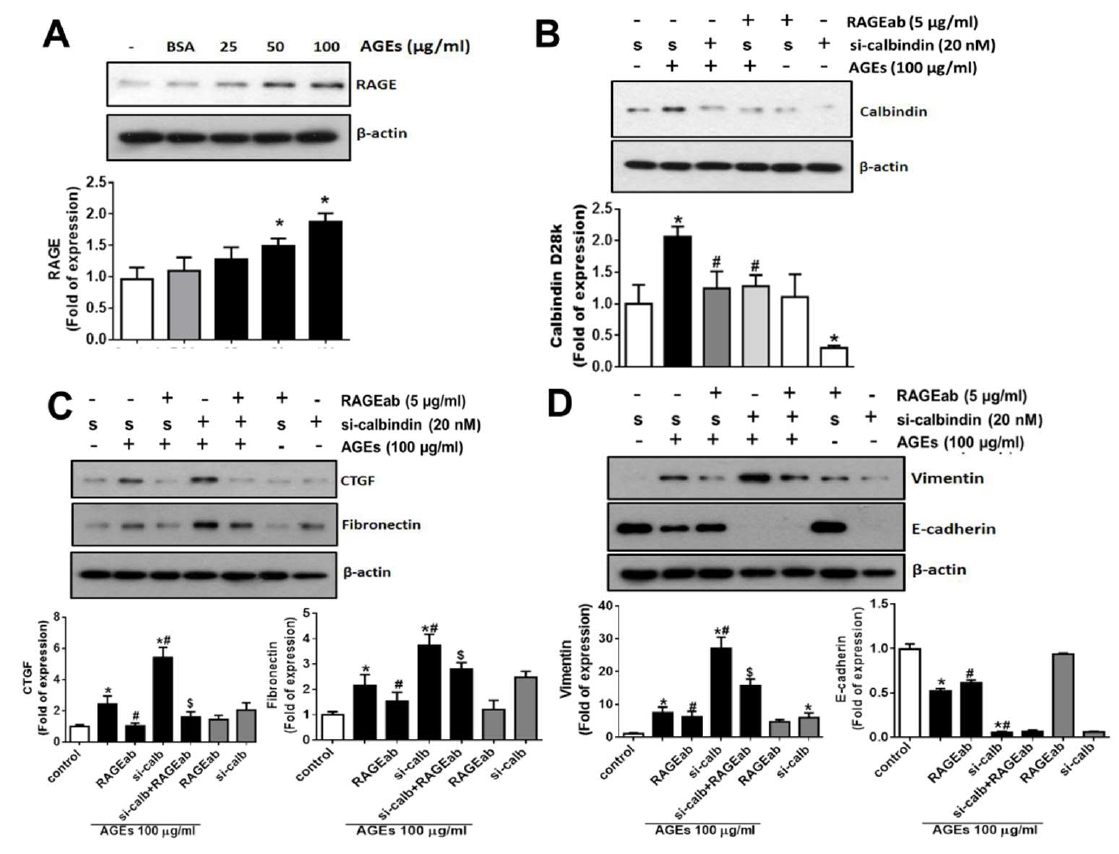
Figure 4. RAGE blockade suppressed AGEs-induced fibrotic signals and calbindin-D28k in the presence or absence of calbindin-D28k silencing in HK2 cells. ( A ) Cells were treated with AGEs (25–100 µ g / mL) or BSA (100 µ g / mL) for 48 h. Protein expressions of RAGE in HK-2 cells were determined by Western blotting. In ( B – D ), cells were transfected with scramble (s or control; 40 nM) or calbindin-D28k siRNA (si-calbindin or si-calb; 40 nM) for 6 h. Transfected cells were treated with RAGE neutralizing antibody (RAGEab, 5 µ g / mL) for 1 h, and then treated with AGEs (100 µ g / mL) for 48 h. Protein expressions of calbindin-D28k ( B ), CTGF and fibronectin ( C ), and vimentin and E-cadherin ( D ) in HK-2 cells were determined by Western blotting. Protein levels were quantified by densitometry and normalized by β -actin levels. Data are presented as means ± SEM (n = 4). * P < 0.05, vs. control or scramble control group. # P < 0.05, vs. AGEs + scramble group. $ P < 0.05, vs. AGEs + calbindin-D28k siRNA group.